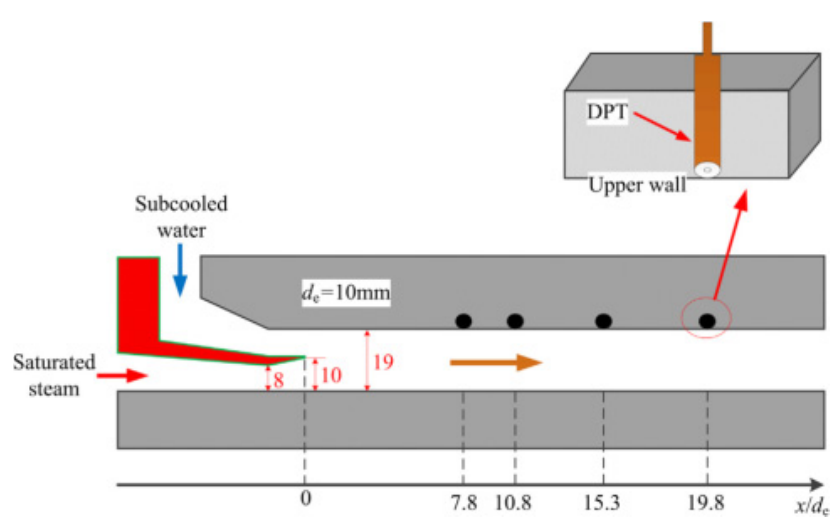
Figure 30. Simplified setup for condensation modelling [93].